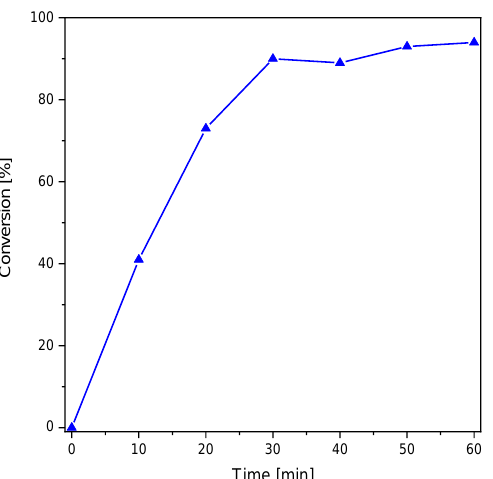
Figure 1. Conversion of S-phenyl thioformate under UV illumination (right, 254 nm, 5.08 mW cm −2 ).